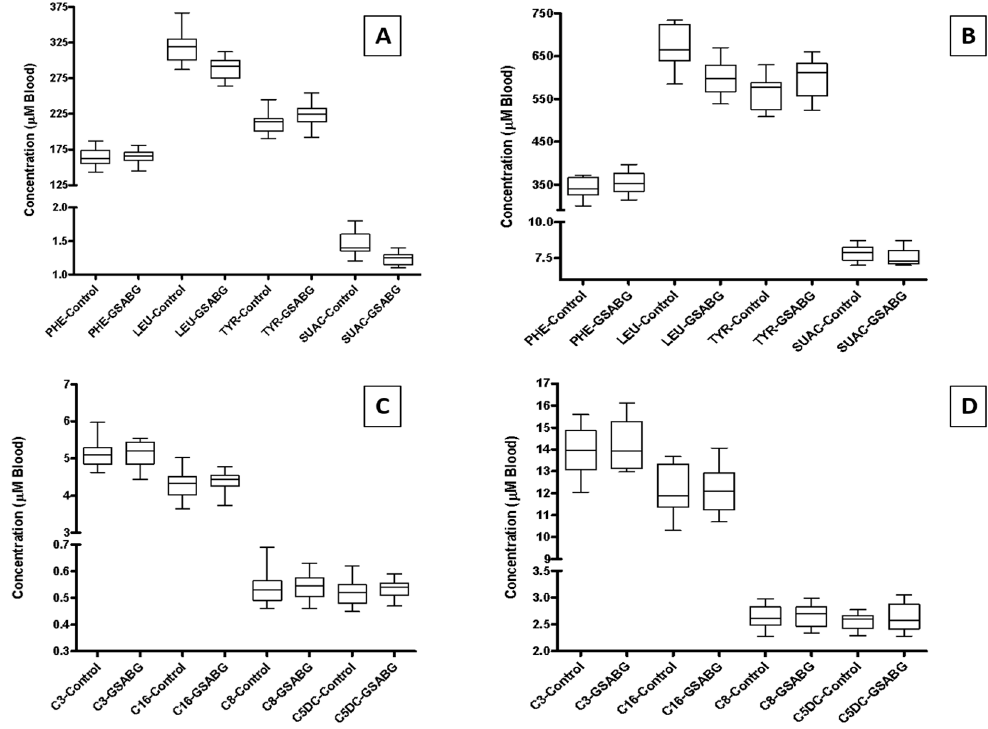
Figure 1. Comparison of selected AA and AC concentrations of QC DBS materials analyzed using a routine non-derivatized method (Control) and a non-derivatized method with CRE and GAA (GSABG): ( A ) Low AAAC QC—AA; ( B ) High AAAC QC—AA; ( C ) Low AAAC QC—AC; ( D ) High AAAC QC—AC. The boxes correspond to the 10th to 90th percentile, the whiskers to the 1st to 99th percentile, and the horizontal line is the median value for the